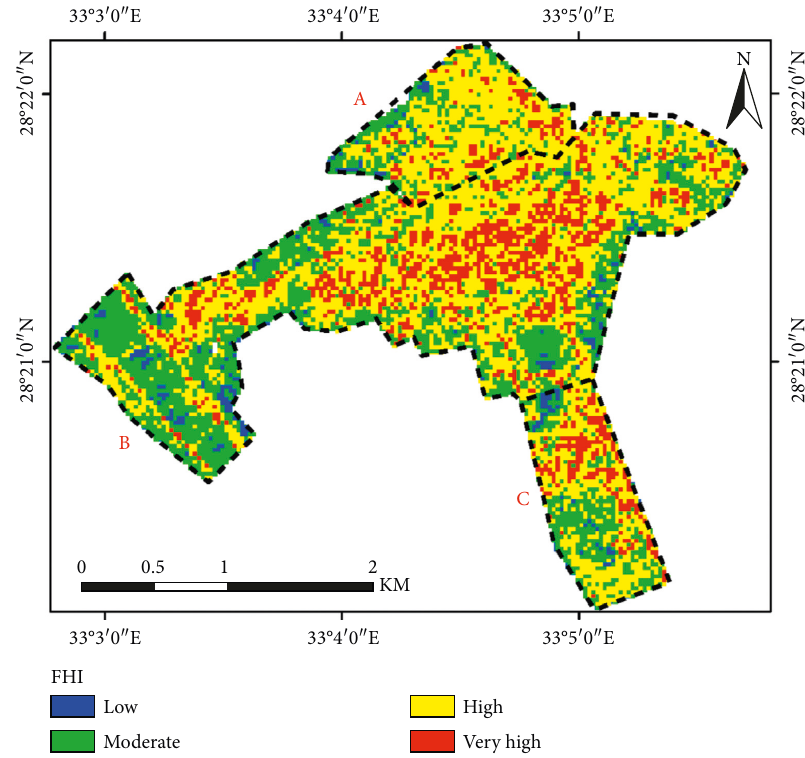
Figure 11: Flood susceptible area of the Ras Ghareb